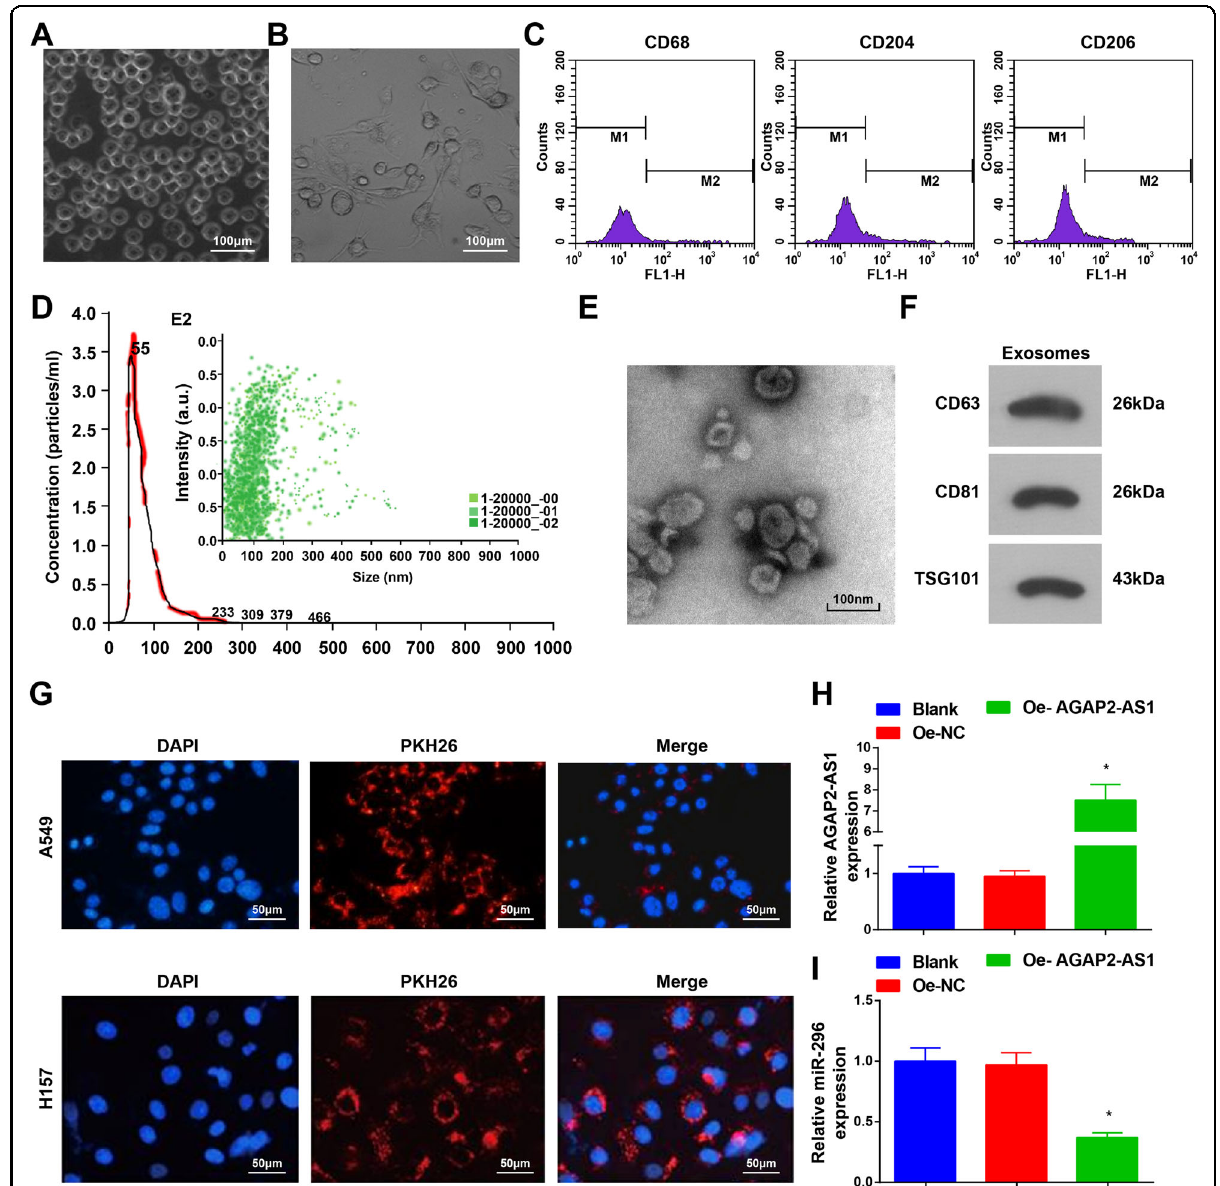
Fig. 4 Identi fi cation of macrophages and macrophage-derived exosomes. A Morphological observation of THP-1 cells. B Morphological observation of PMA-induced macrophages. C Macrophages were identi fi ed by fl ow cytometry. D diameter distribution and particle concentration of exosomes were observed by Nanosight. E Exosome morphology was observed under a TEM. F Expression of CD63, CD81, and TSG101 was measured by Western blot analysis. G Uptake of exosomes. H AGAP2-AS1 expression in macrophages. I miR-296 expression in macrophages; N = 3, * P < 0.05 vs. the Oe-NC group; the measurement data were expressed as mean ± standard deviation, one-way ANOVA was used for comparisons among multiple groups and Tukey ’ s post hoc test was used for pairwise comparisons after one-way